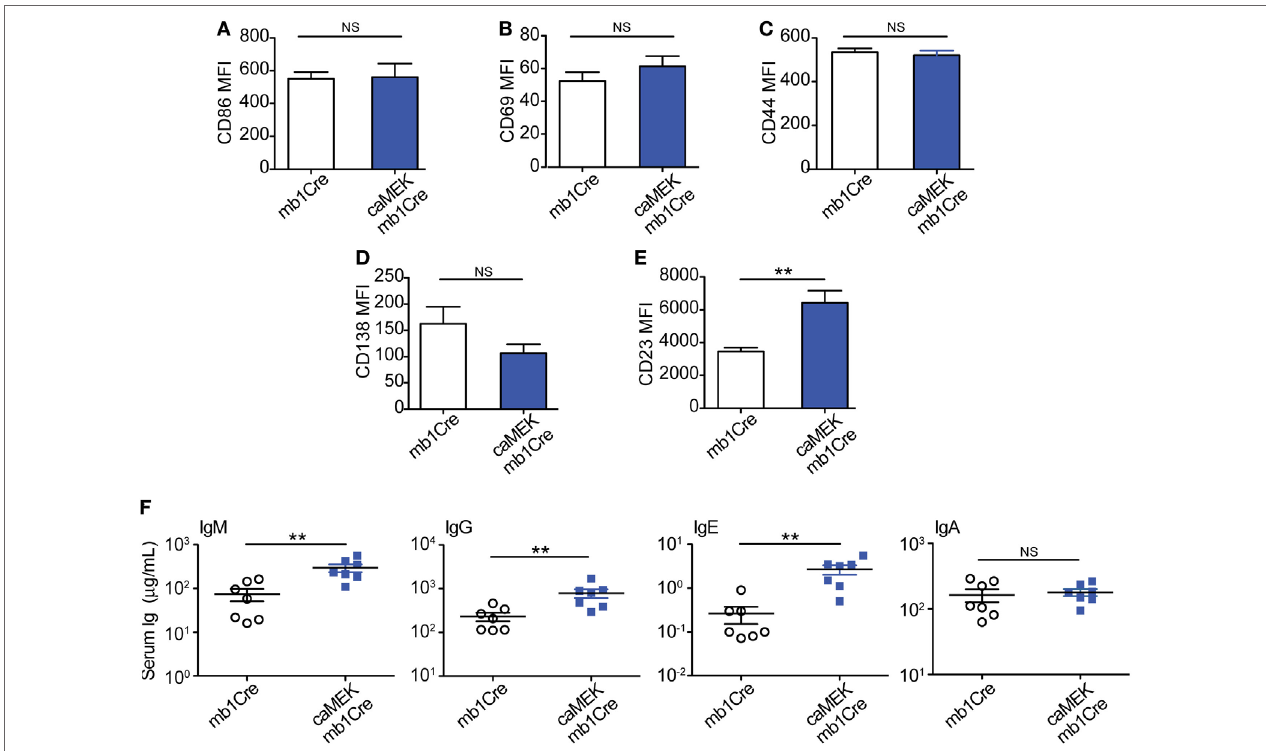
FigUre 6 | B cell-specific expression of caMEK does not induce B cell activation, but increases serum Ig levels. (a–e) MFI levels of (a) CD86, (B) CD69, (c) CD44, (D) CD138, and (e) CD23 on splenic B220 + B cells from 3-83Igi, H-2 b mb1Cre and B220 + GFP + B cells R26-LSL-caMEK-GFP-mb1Cre mice. N = 9 total 3-83Igi,H-2 b -mb1Cre mice and N = 7 total 3-83Igi,H-2 b -R26-LSL-caMEK-GFP-mb1Cre mice, analyzed in four independent experiments. (F) Concentrations ( μ g/mL) of total IgM, IgG, IgE, and IgA in the sera of 3-83Igi,H-2 b -mb1Cre littermate controls ( N = 7, open circles) and 3-83Igi,H-2 b -R26-LSL-caMEK-GFP-mb1Cre ( N = 7, filled squares) mice. ** P ≤ 0.01; NS, not